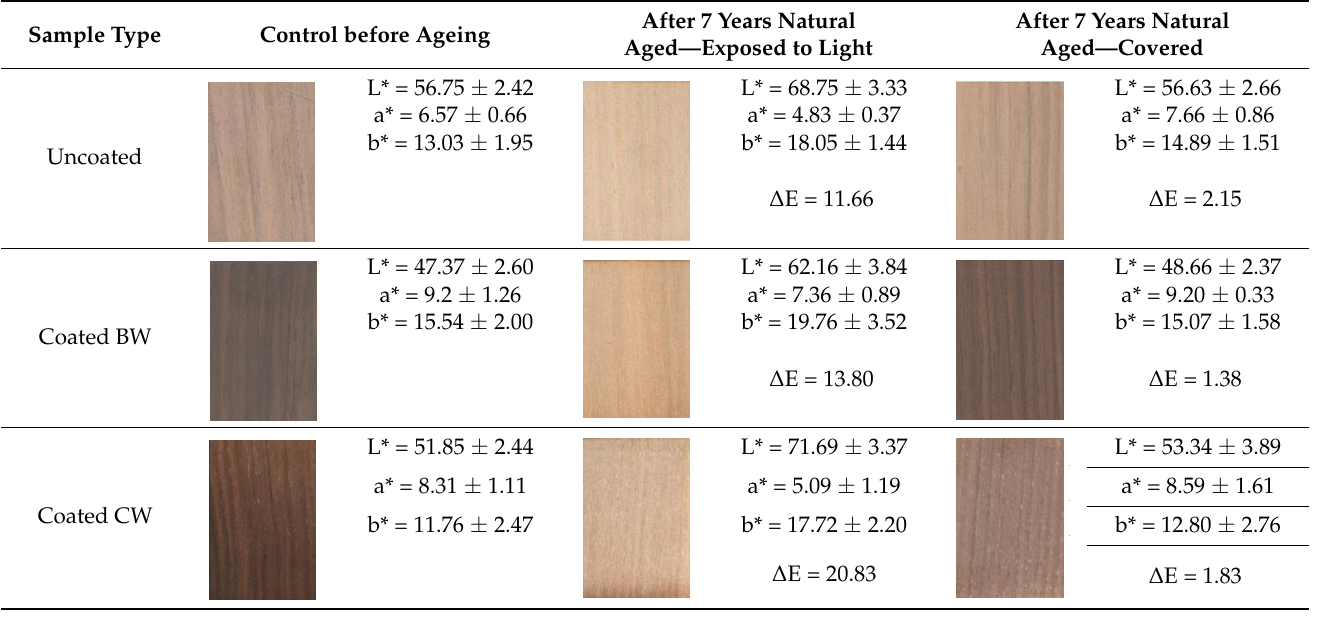
Table 3. Visual assessment and colour measurement of European walnut wood ( Juglans regia ) before and after natural ageing.